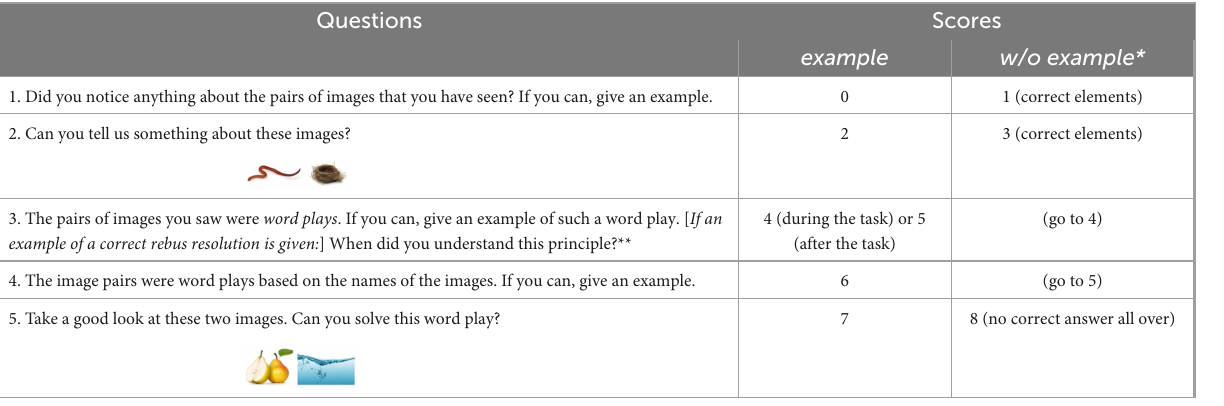
TABLE 2 Funnel debriefing in FW (forward) variation of Experiment